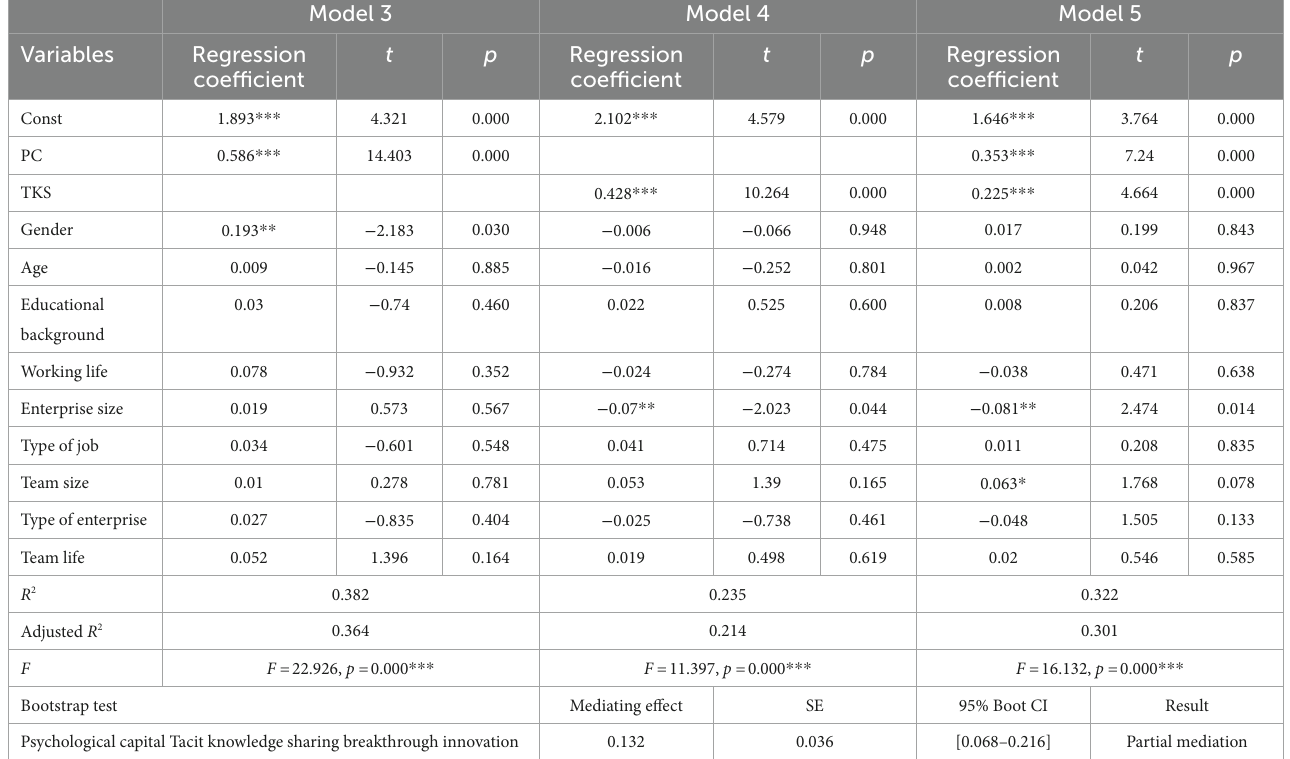
TABLE 7 Regression analysis of the mediating effect of Tacit knowledge